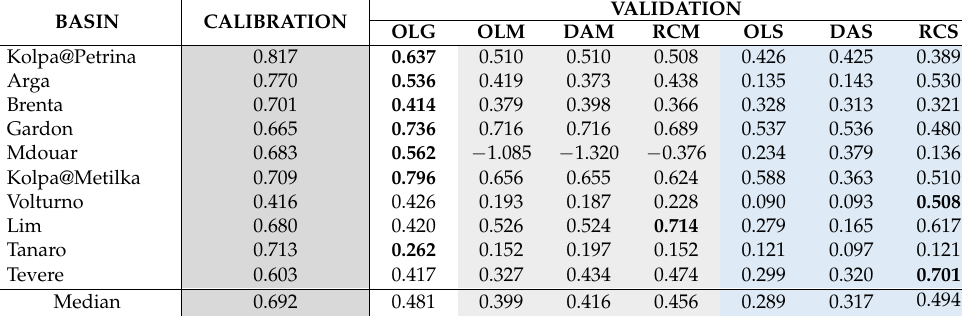
Table 3. Kling-Gupta performance index obtained during calibration by forcing the model with P EOBS (CALIBRATION in dark grey) and during the validation period (VALIDATION in light grey and blue) for (1) MISDc model forced with P EOBS (OLG in white), (2) MISDc model forced with P ERA and P 3B42RT (OLM, OLS), (3) the state correction scheme (DAM, DAS) and (4) the rainfall correction scheme (RCM, RCS). Numbers in bold refer to the best score obtained in validation among OLG, OLM, DAM, RCM, OLS, DAS and RCS.